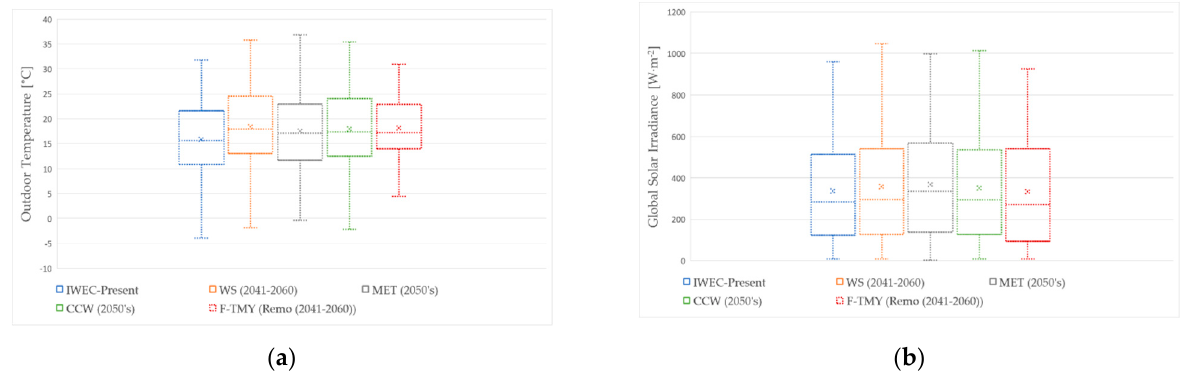
Figure 2. Boxplots of the outdoor dry-bulb temperature ( a ) and the global horizontal solar irradiance during daily hours ( b ) for IWEC (Present), Weathershift (WS), Meteonorm (MET), CCWorldWeatehr-Gen (CCW), and F-TMY. All future weather files are for 2050s considering Representative Concentration Pathway (RCP) 8.5.